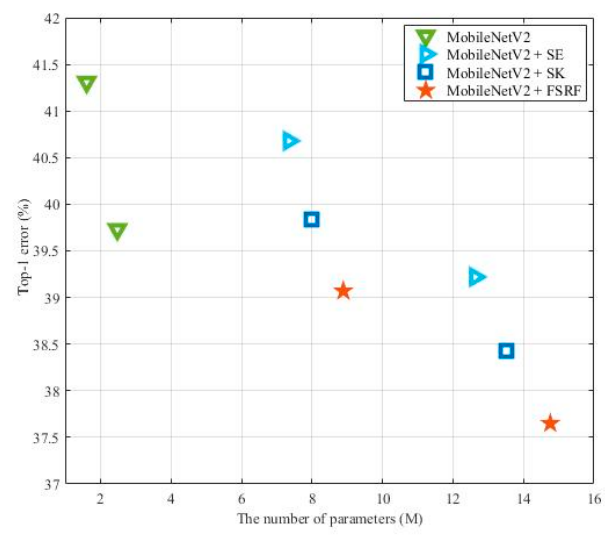
Figure 7. Relationship between performance and the number of parameters: FSRFNet compared with the corresponding lightweight model MobileNetV2.